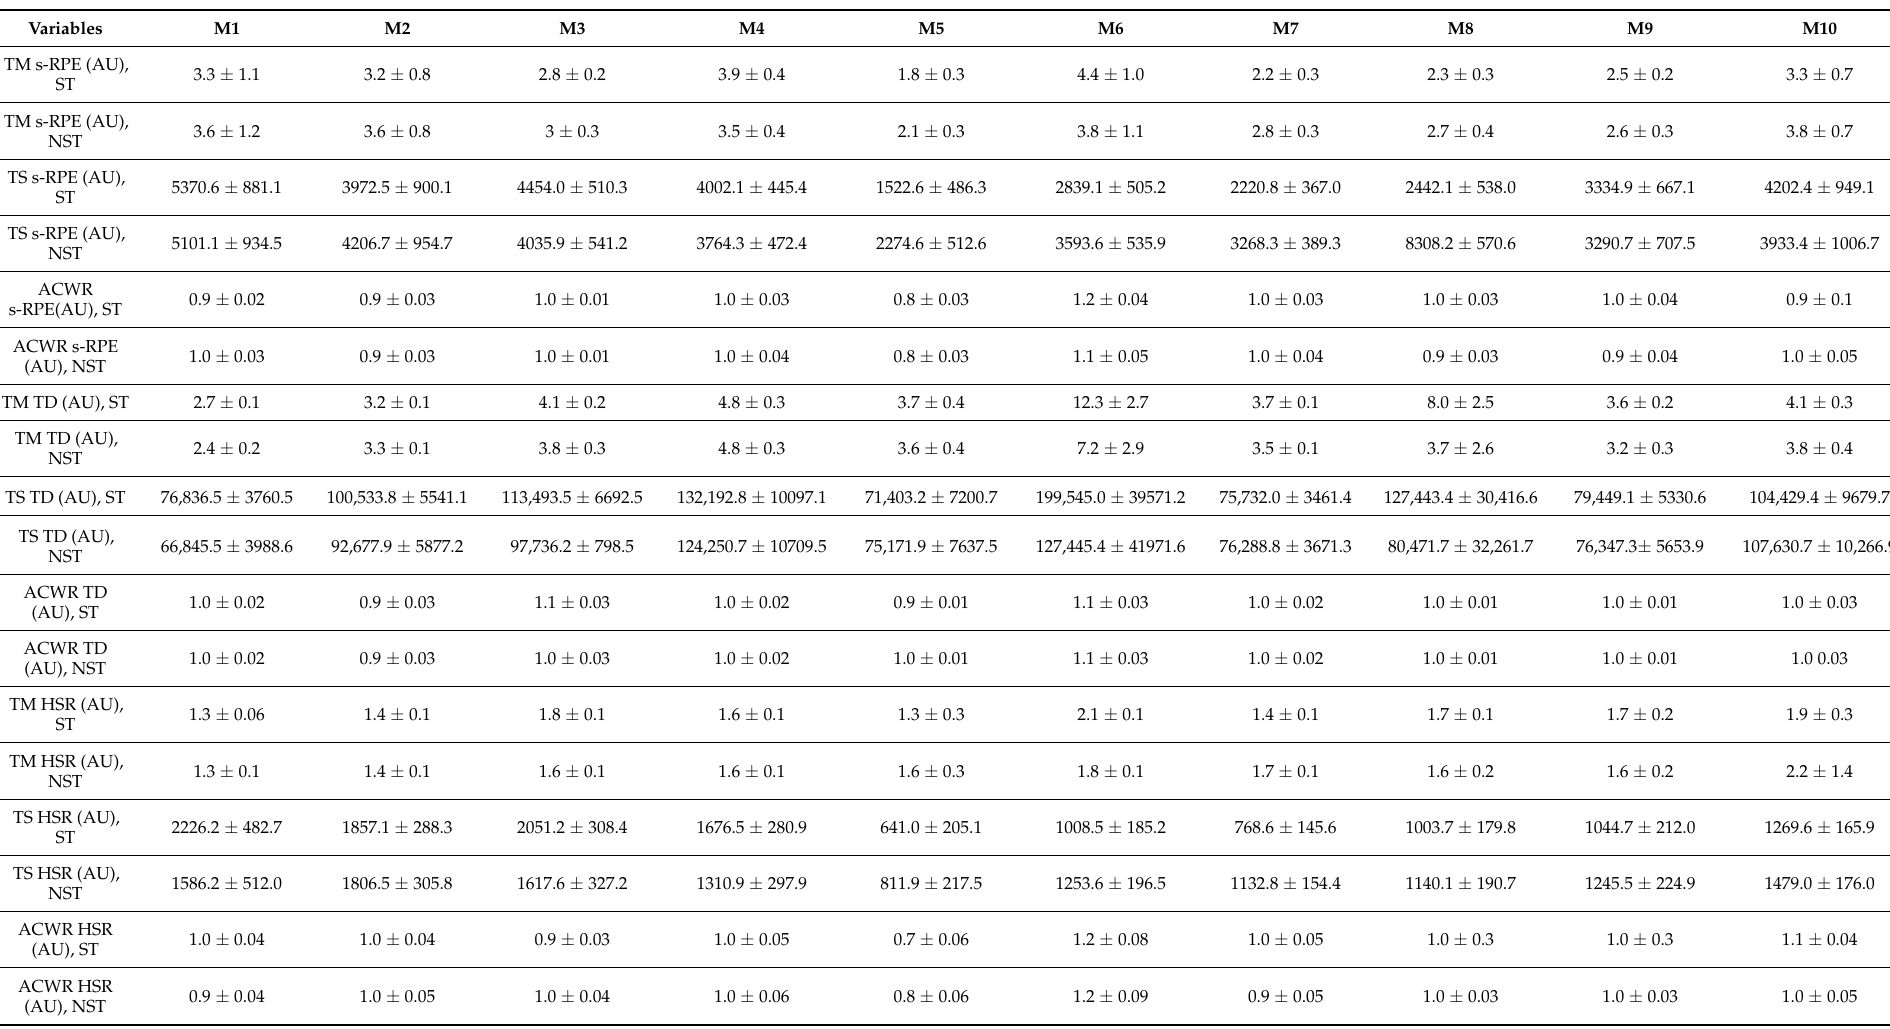
Table 2. Differences between starters and non-starters during the 10 mesocycles, mean ±